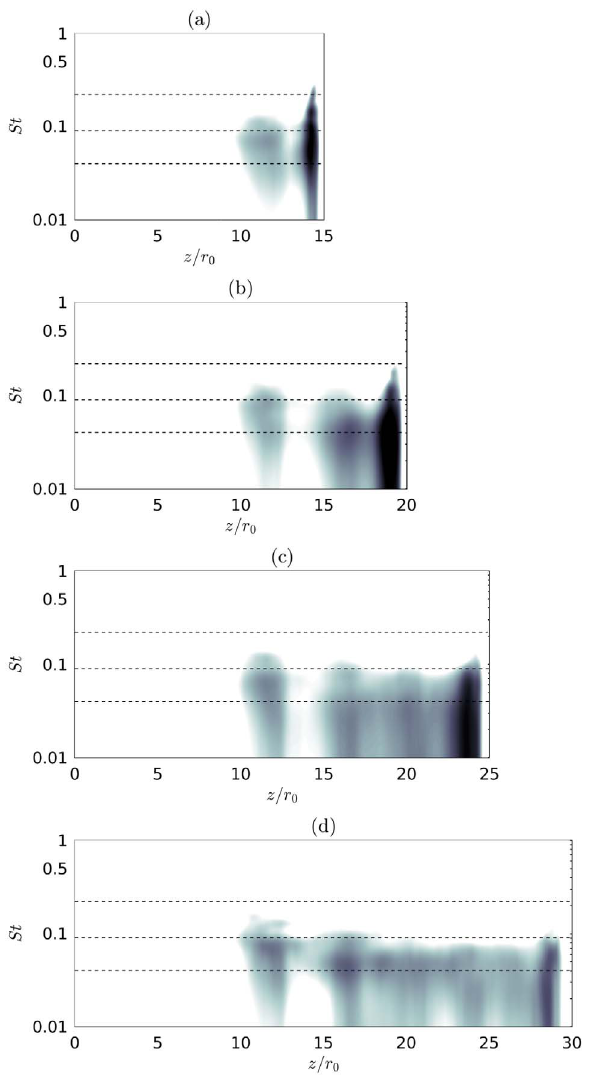
Figure 11. Power spectral densities of the fl uctuations of axial velocity u 0 z at r = r 0 between z = 0 and L for (a) L = 15 r 0 , (b) L = 20 r 0 , (c) L = 25 r 0 and (d) L = 30 r 0 . The color scale is the same in the three cases and spreads over 3 dB, from white to black. The black dashed lines indicate the frequencies St = 0.04, 0.09 and 0.22.